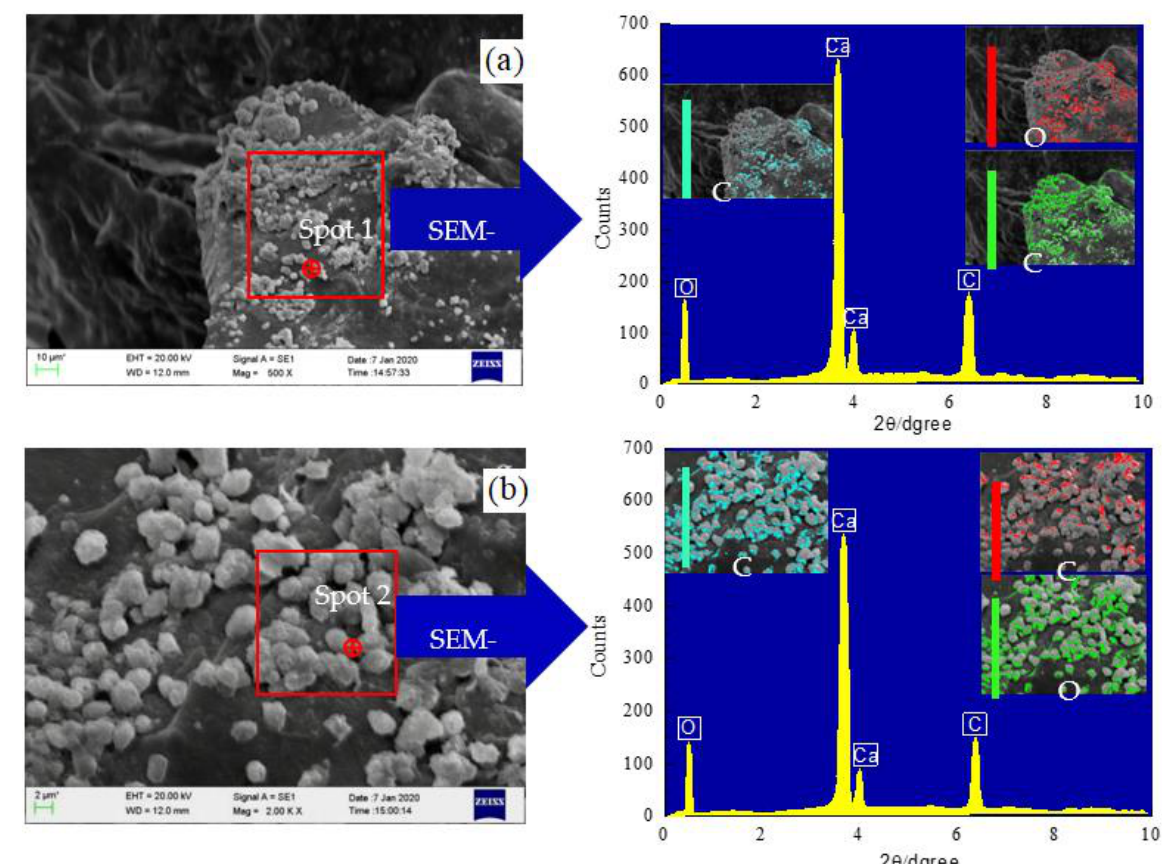
Figure 10. SEM – EDS analysis. ( a ) T = 15 ℃ , ( b ) SC = 0.5 mol/L Figure 10. SEM–EDS analysis. ( a ) T = 15 °C, ( b ) SC = 0.5